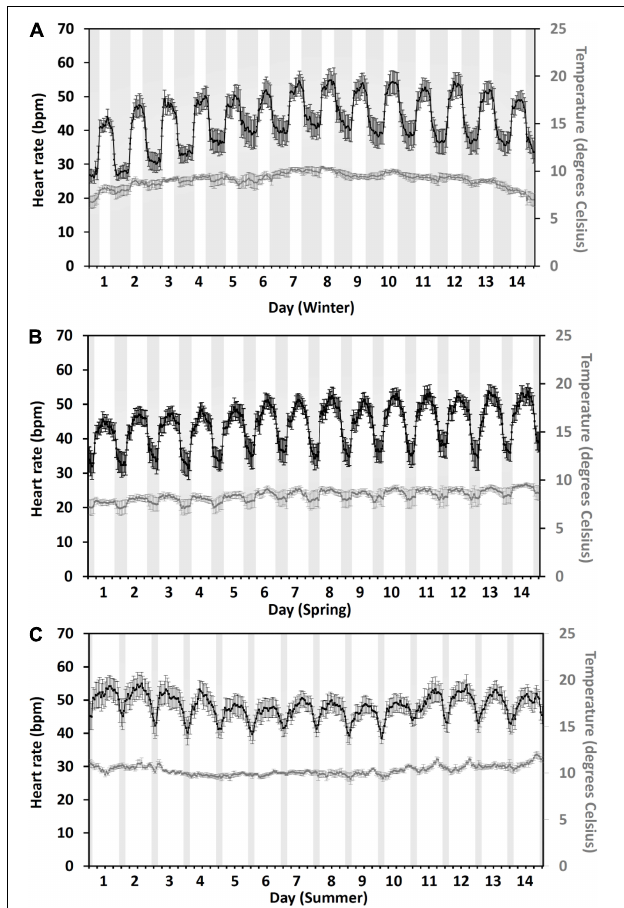
FIGURE 3 | Fourteen-day, hourly mean heart rate (black) in bpm and temperature (gray) of 17 fish during winter (A) , spring (B) , and summer (C) . Gray bands indicate civil hours of darkness to the nearest hourly heart rate measurement (winter: the 24th of February ∼ 15 h, 17:00–08:00, decreasing to ∼ 13 h by the 8th of March, 18:00–07:00; spring: the 17th to the 30th of April ∼ 8 h, 21:00–05:00; summer: the 2nd to the 15th of June ∼ 3 h, 00:00–03:00. Error bars represent ± 95%